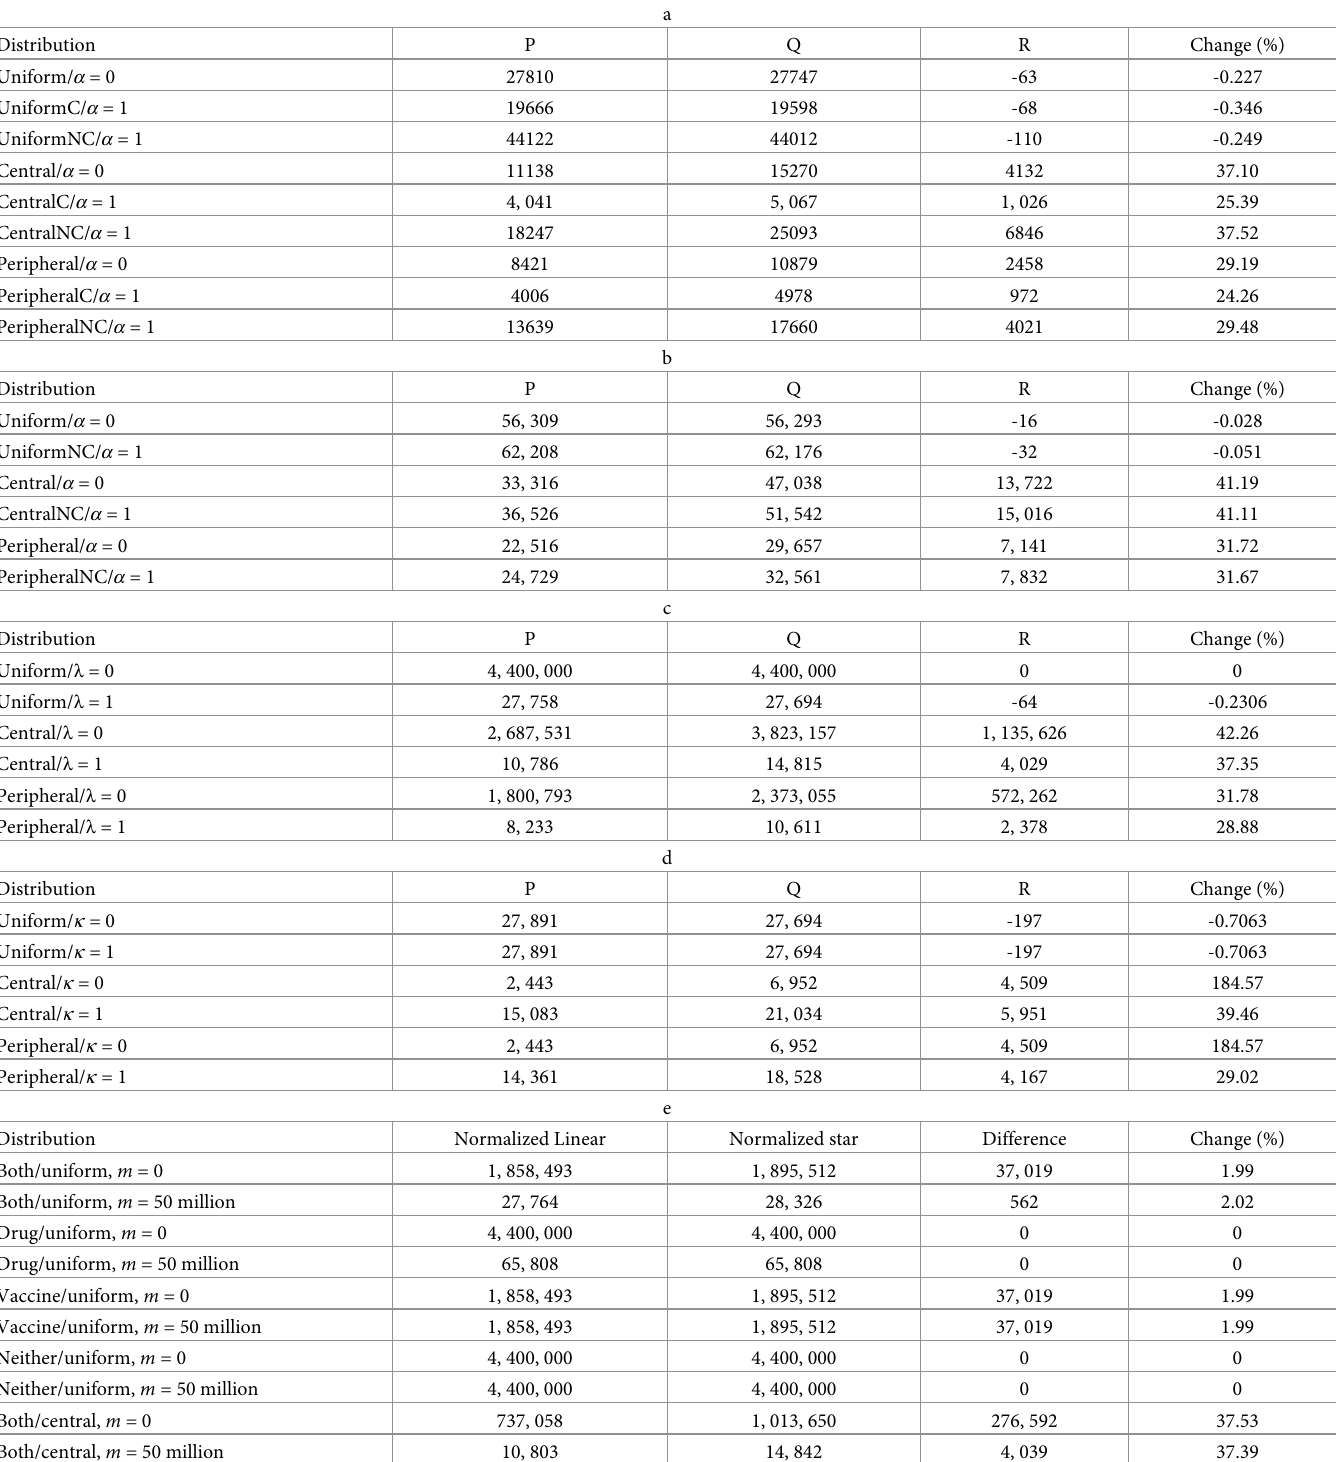
Table 3. Per cluster fatality. The five tables respectively compare the per cluster fatality counts for the “both drug and vaccine” scenario for different opinion spread rates ( α ) (Table 3a and 3b), preemption scale factor ( λ ) (Table 3c), mobility rates ( κ ) (Table 3d), and drug supply ( m ) (Table 3e). In these tables, the first column (P) represents Normalized linear, the second column (Q) represents Normalized star, and the third column (R) provides Q − P , the fourth column, Change = 100 × R / P